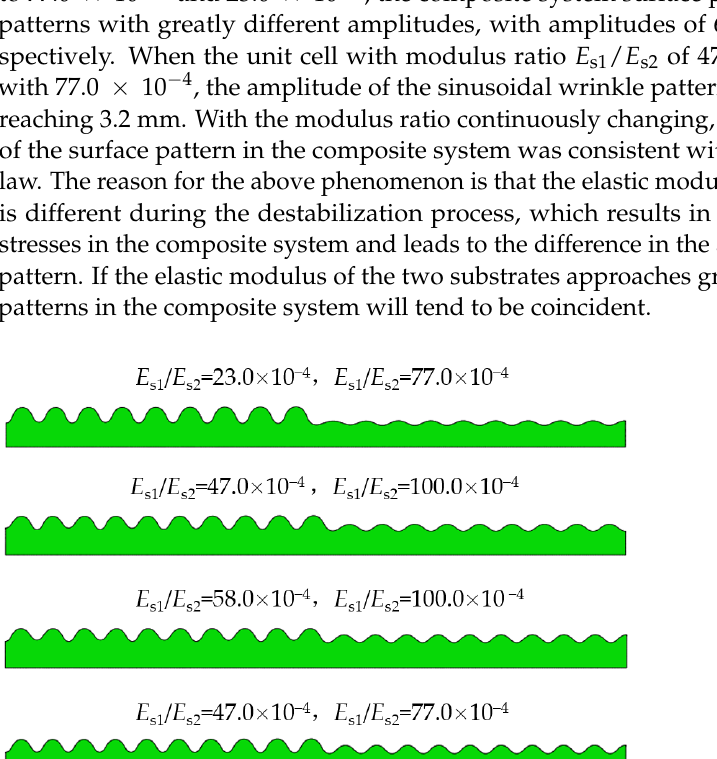
Figure 3. Influence of thickness ratio H f / H s on the composite instability morphology.